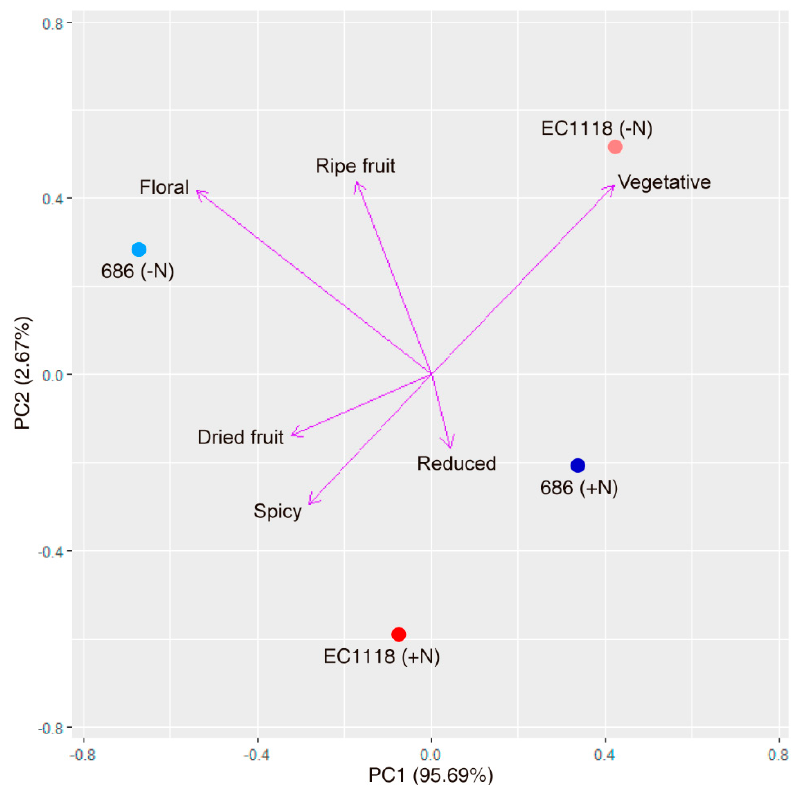
Figure 4. PCA plot for aroma attributes of wines produced. The relative position of the wines produced by the two strains (686 and EC1118) from supplemented ( + N) and non-supplemented ( − N) musts are shown for the six aroma descriptors analysed (reduced, spicy, dried fruit, ripe fruit, floral and vegetative).